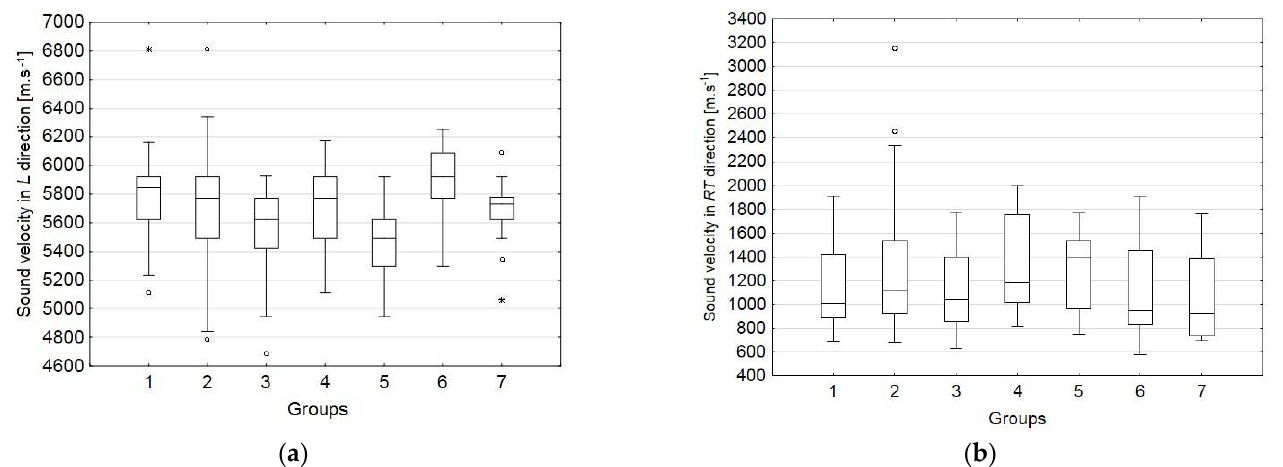
Figure 6. Sound velocity in longitudinal ( a ) and transversal ( b ) directions. Group description: ( 1 ) 20 ◦ C 40% unmodified; ( 2 ) 20 ◦ C 60% unmodified; ( 3 ) 20 ◦ C 80% unmodified; ( 4 ) 20 ◦ C 60% modified at 180 ◦ C; ( 5 ) 20 ◦ C 80% modified at 180 ◦ C; ( 6 ) 20 ◦ C 60% modified at 200 ◦ C; ( 7 ) 20 ◦ C 80% modified at 200 ◦ C. ◦ —outlier values; *—extreme